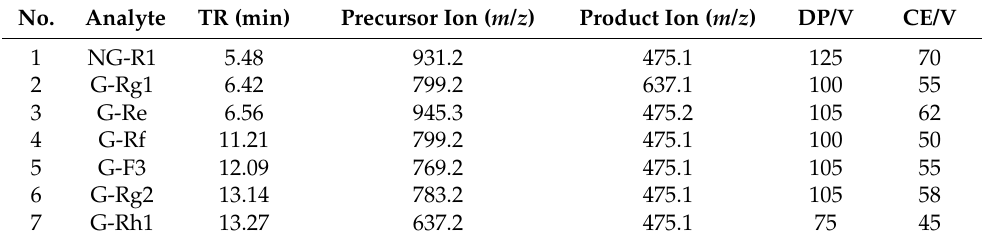
Table 2. The retention time, precursor ions, product ions, and multiple reaction monitoring (MRM) parameters of the 16 analytes in the negative ion mode. Retention time (TR), declustering potential (DP), apillaryelectrophoresis